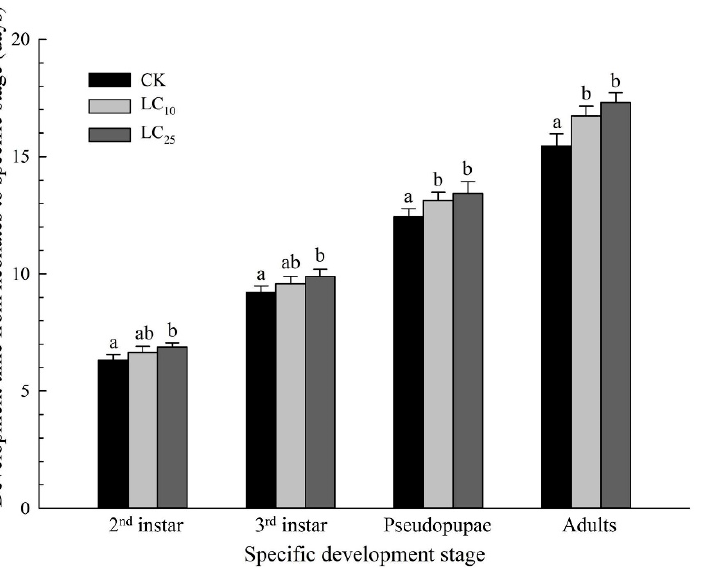
Figure 1. Sublethal effects of afidopyropen (LC 10 and LC 25 ) on development time in specific life stages of B. tabaci MED. CK denotes the control group, and diverse letters display significant differences ( p < 0.05).